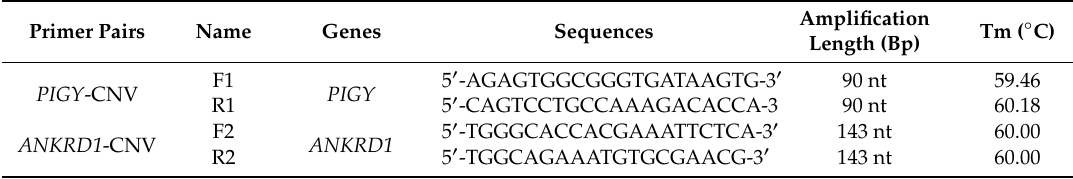
Table 1. The primer information used in this study.